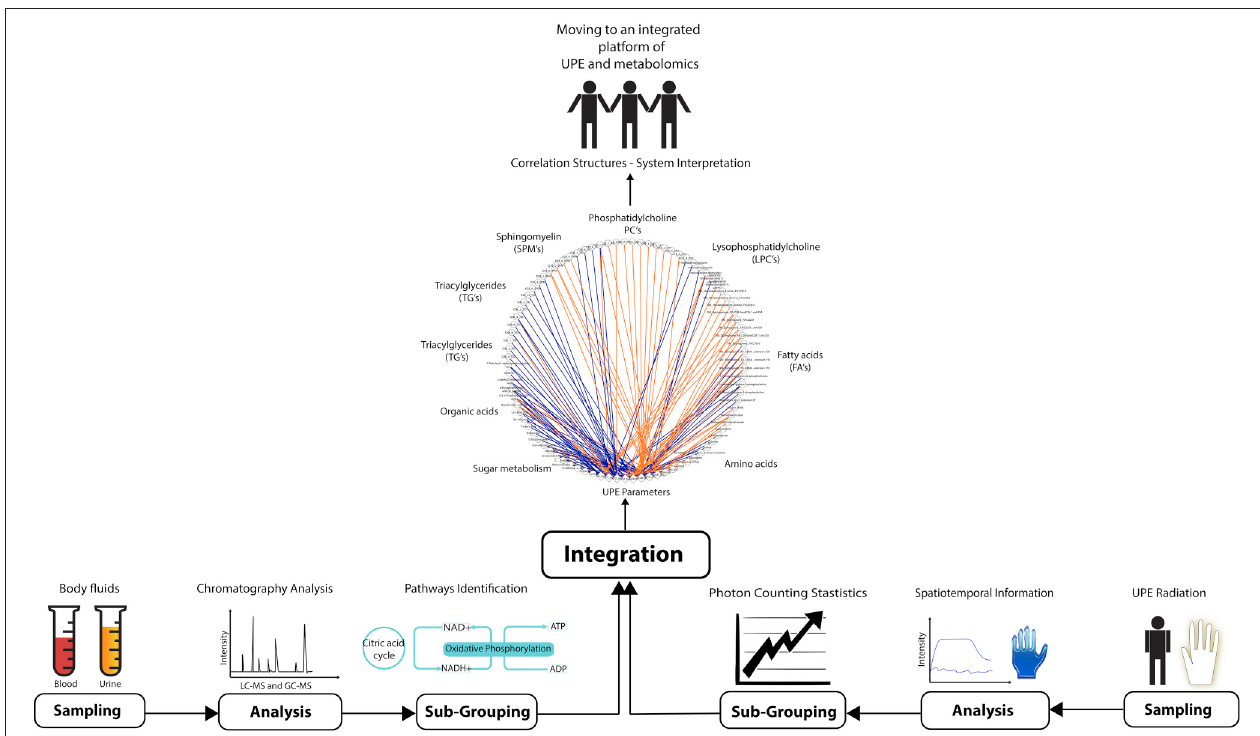
FIGURE 2 | Overview of the experimental steps required for integrating UPE and metabolomics data in order to promote health and diagnostics. Bodily fluids (for metabolomics; left) and parts of the body (for UPE recording; right) are sampled. The samples are analyzed using chromatographic techniques (for metabolomics) and spatiotemporal analyses (for UPE). The metabolomics data are then gathered in pathways, and photon counting statistics is applied to the UPE data. Finally, the two data sets are integrated performing Spearman’s rank correlations using network correlation, ultimately generating a systems-based interpretation. In this example, plasma samples of pre-diabetic subjects (44 individuals) were analyzed for the generation metabolomics data. The metabolomics study used GC-MS and LC-MS platforms to profile lipids (phosphatidylcholine, lysophosphatidylcholine, sphingomyelin, fatty acids, and triglycerides), organic acids, sugar metabolites, and amine metabolites. UPE data was acquired from the subjects’ hands generating 13 parameters after applying photon count statistics. Spearman’s rank correlations was calculated between UPE parameters and various classes of compounds acquired from the metabolomics analysis. The correlation was filtered using |r| > 0.3 and subsequently built the correlation network using CytoScape software (MetScape plugin). Blue lines represent negative correlations, and orange lines represent positive correlations. The study was designed and conducted by TNO (Zeist, the Netherlands). The clinical trial